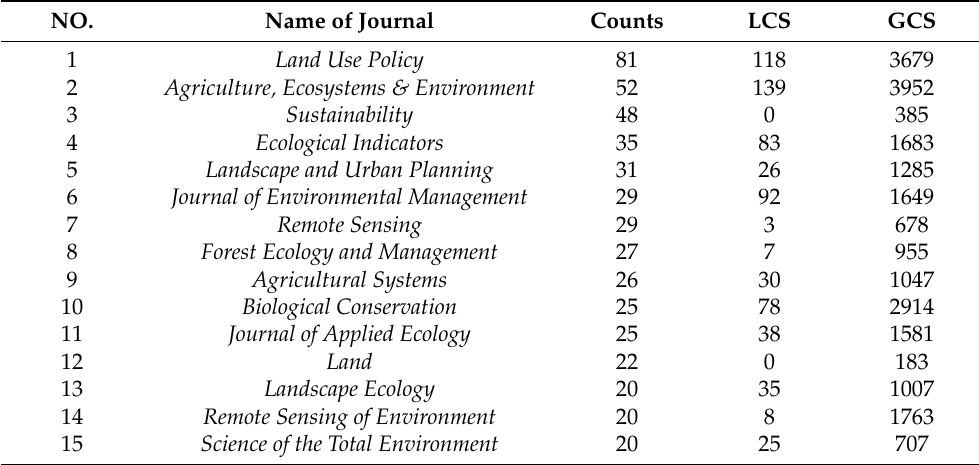
Table 3. Top 15 journals and their co-citations on the topic of agricultural land function.